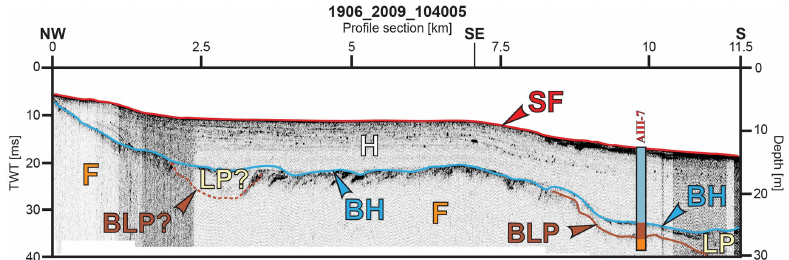
Figure 3. An example of an acoustic profile, acquired along the northern coast of the Istria Peninsula, which is correlated with the core AIII-7 from Ogorelec et al. (1997) (SF: seafloor, H: Holocene marine sediment, BH: reflector that marks the base of the Holocene sediment, LP: Late Pleistocene sediment, BLP: base of the Late Pleistocene sediment, F: flysch, TWT: two-way travel time). For the location of the profile, see Fig. 5.